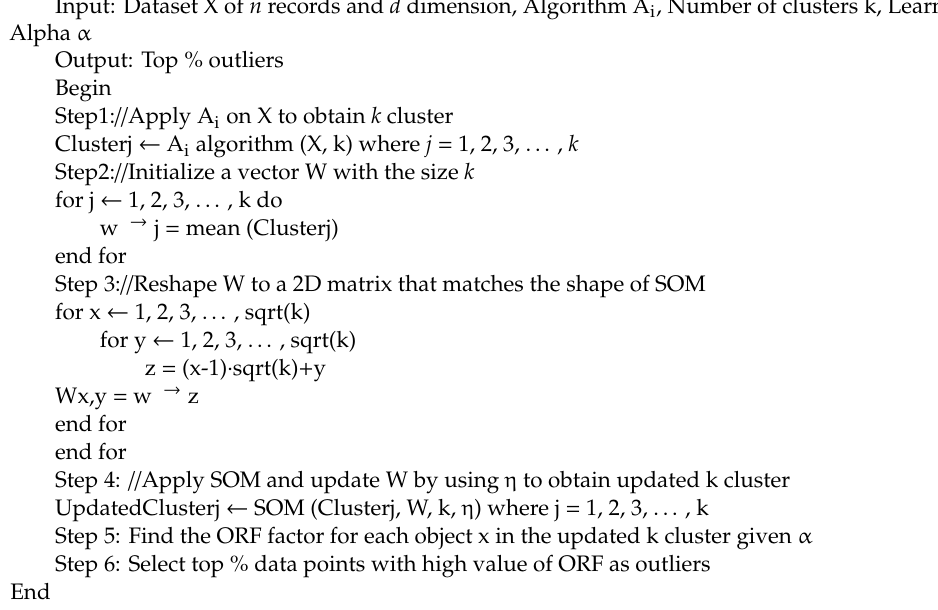
Algorithm 1 Multi-Level Clustering-Based Outlier’s Detection (MCOD)